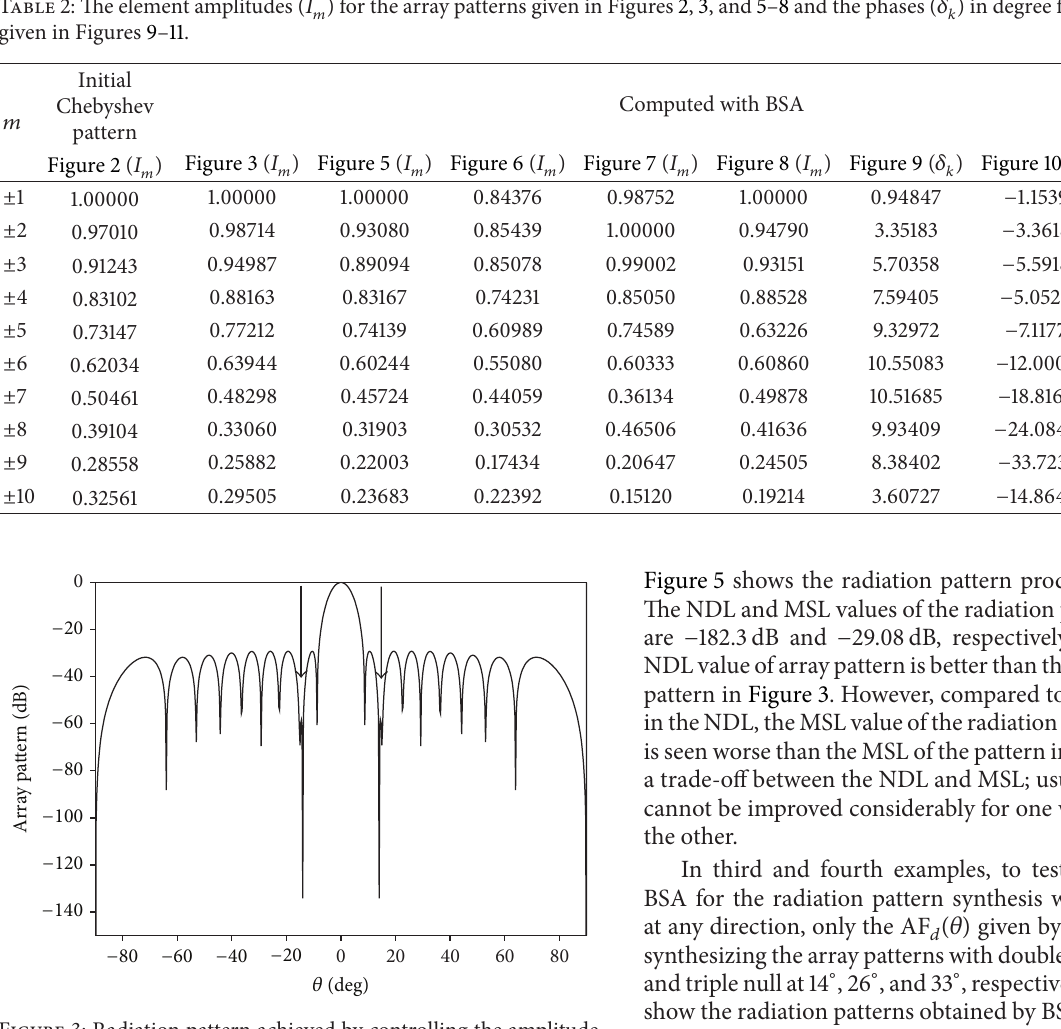
Table 2: The element amplitudes ( 𝐼 𝑚 ) for the array patterns given in Figures 2, 3, and 5–8 and the phases ( 𝛿 𝑘 ) in degree for the array patterns given in Figures 9–11.